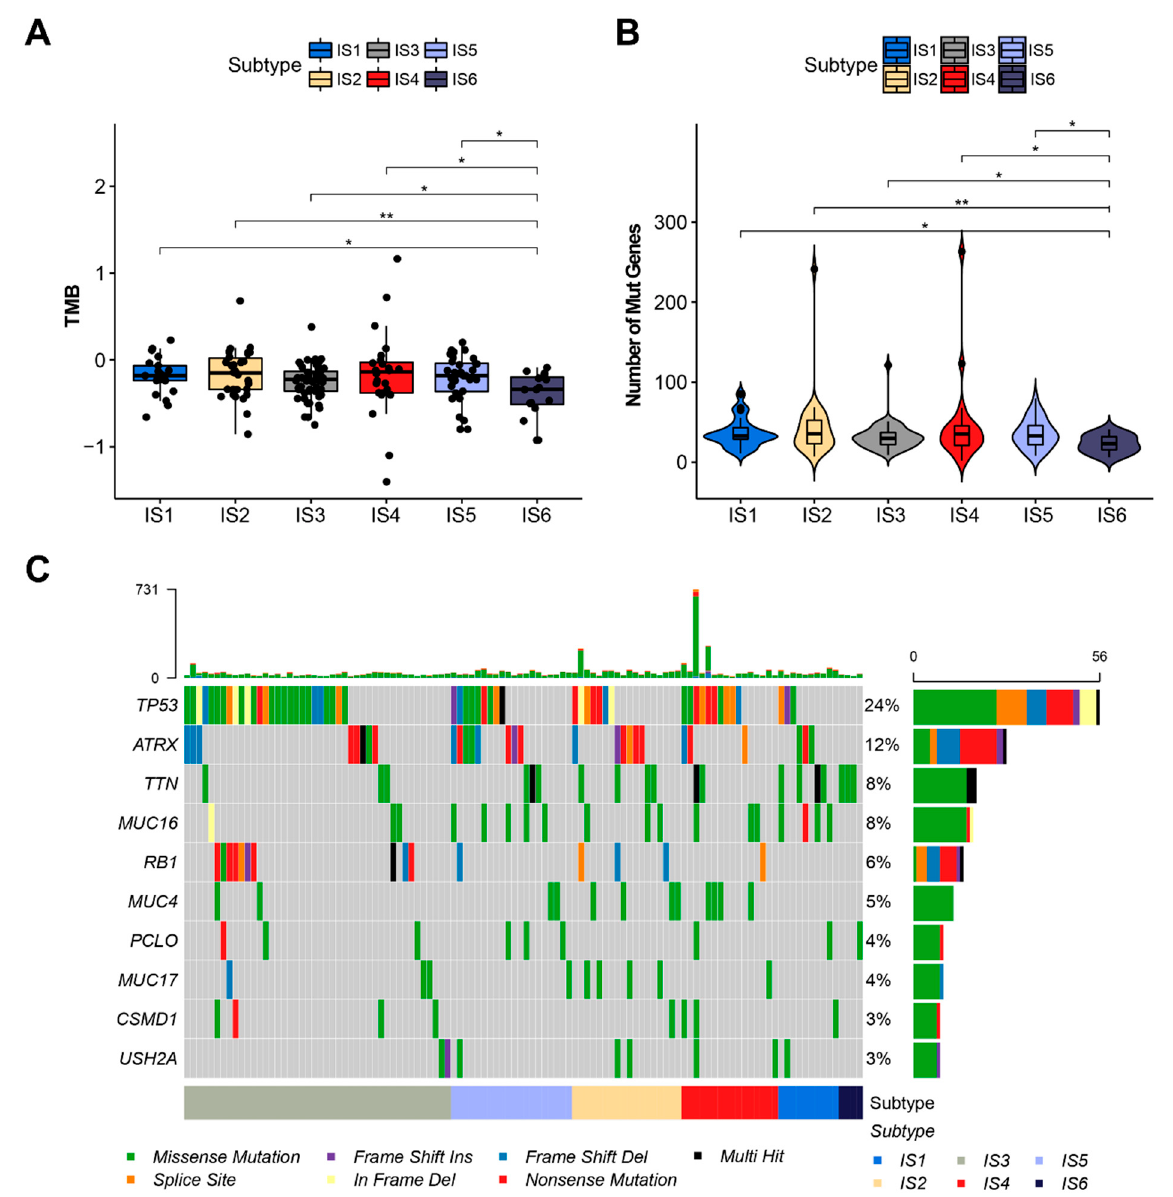
Figure 4. Association of immune subtypes with TMB and mutation in STS. ( A , B ) TMB ( A ) and mutation number ( B ) of different immune subtypes in STS. ( C ) The top 10 frequently mutated genes in STS immune subtypes. * p < 0.05 and ** p <